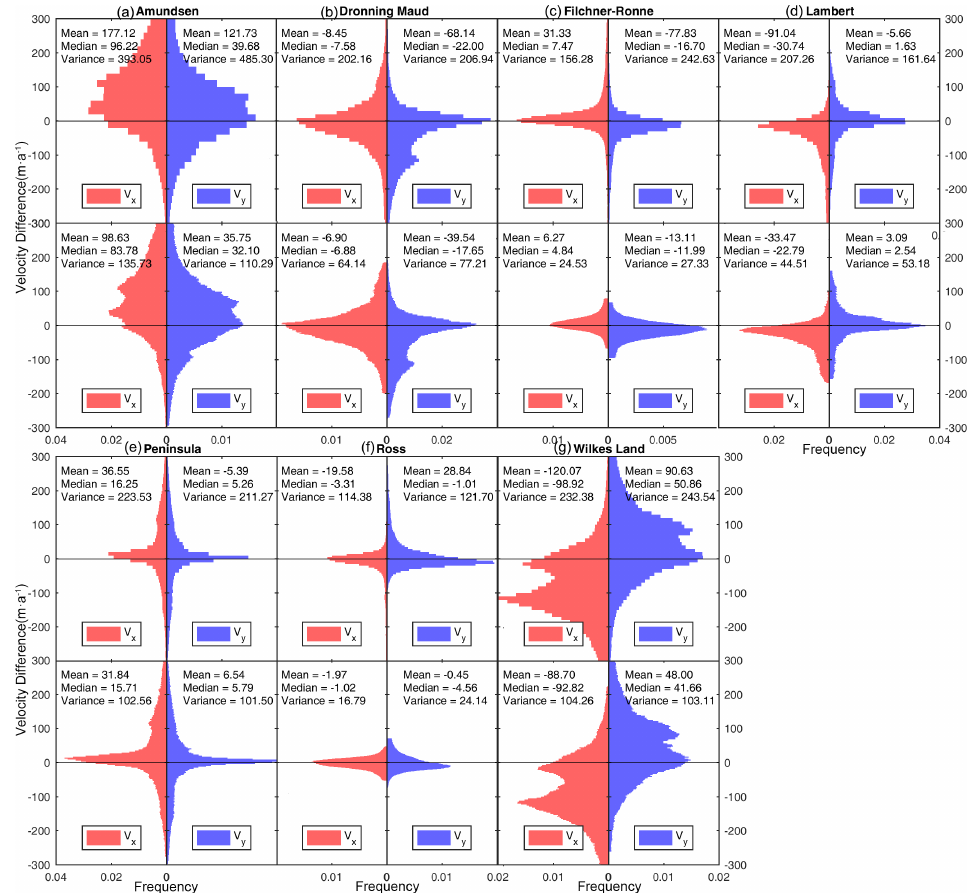
Figure 6. Distribution of difference between MOA-based velocity and MEaSUREs velocity, before (upper row) and after (lower row) the Butterworth filter and the 3 σ truncation iteration, in seven drainages: ( a ) Amundsen, ( b ) Dronning Maud, ( c ) Filchner-Ronne, ( d ) Lambert, ( e ) Peninsula, ( f ) Ross, and ( g ) Wilkes Land, respectively. Note that the value of all three statistics, mean, median, and variance, drops after the operations.